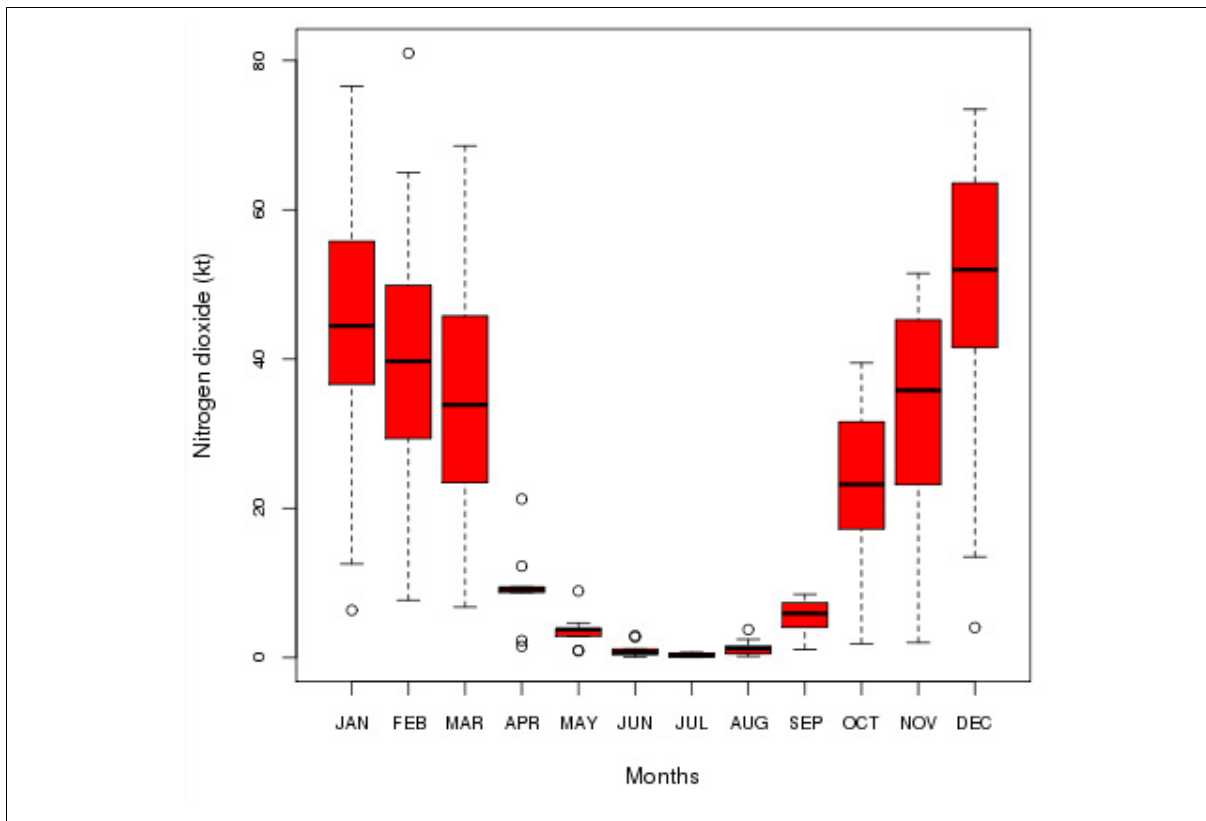
Figure 6: Monthly estimates of LNOx over South